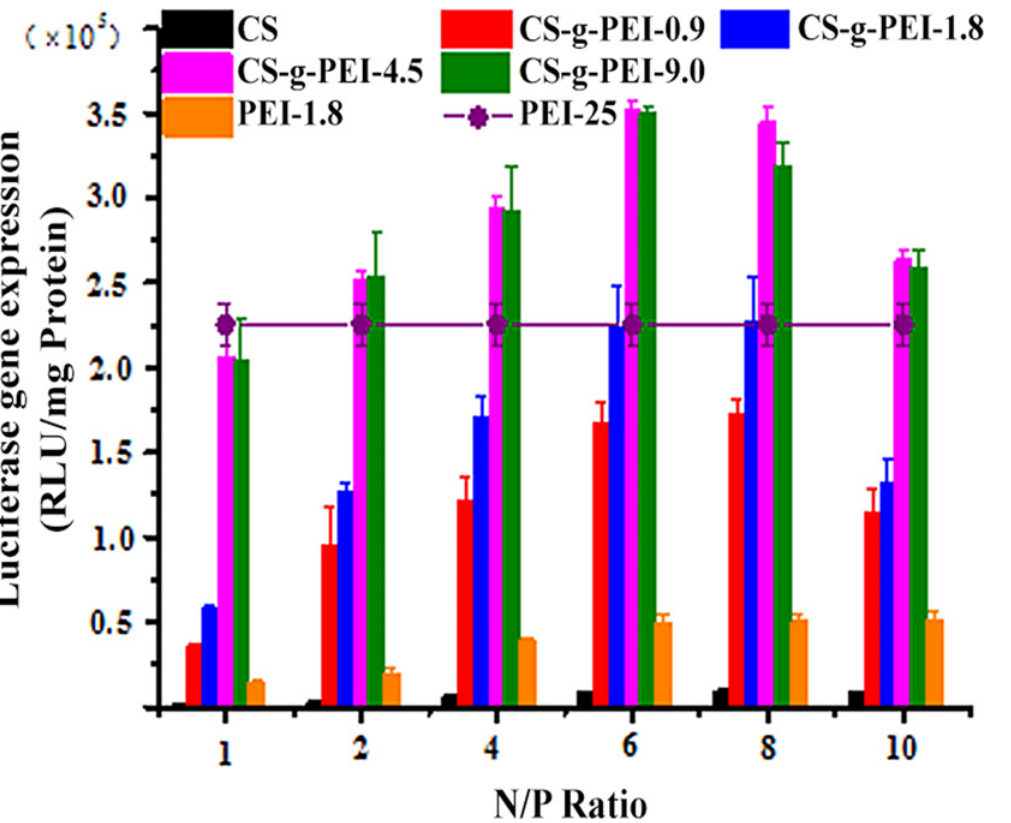
Fig 9. Luciferase expression in HEp-2 cells. Transfection with CS/pDNA and CS- g -PEI/pDNA polyplexes at various N/P ratios using pGL3 as report gene, PEI-25 as positive